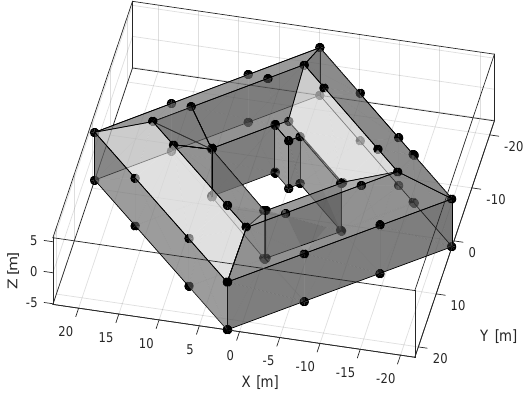
Figure 1. Building with the id 1277 from the Linz data-set. The building’s floor has been modeled by a 2-connected